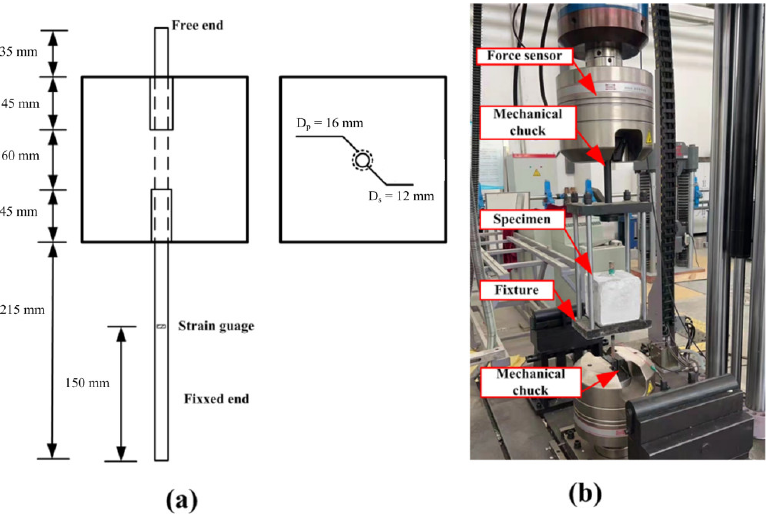
Figure 5. Pullout test: ( a ) design of specimen; and ( b ) setup of the pull-out experiment. For the purpose of verifying the effectiveness of the cohesive parameters obtained from pullout tests, the corresponding numerical model was established. The steel property was adopted for the space occupied by the steel bar, and the CDP model was adopted for the other parts. In addition, the cohesive elements with zero thickness were inserted between the concrete and steel bars, and the material parameters for the cohesive elements are shown in Table 3. Similar to the setup in the experiment, the ending of the unbonded steel bar below was fixed completely. Additionally, the unbonded steel bar above was set to move freely only in the vertical direction. Surface to surface contact was applied between the concrete and the fixed device. In the simulation, the fixed device was assumed to be a rigid body, and a constant loading rate v = 0.01 m/s was applied to the reference point on the fixed device.